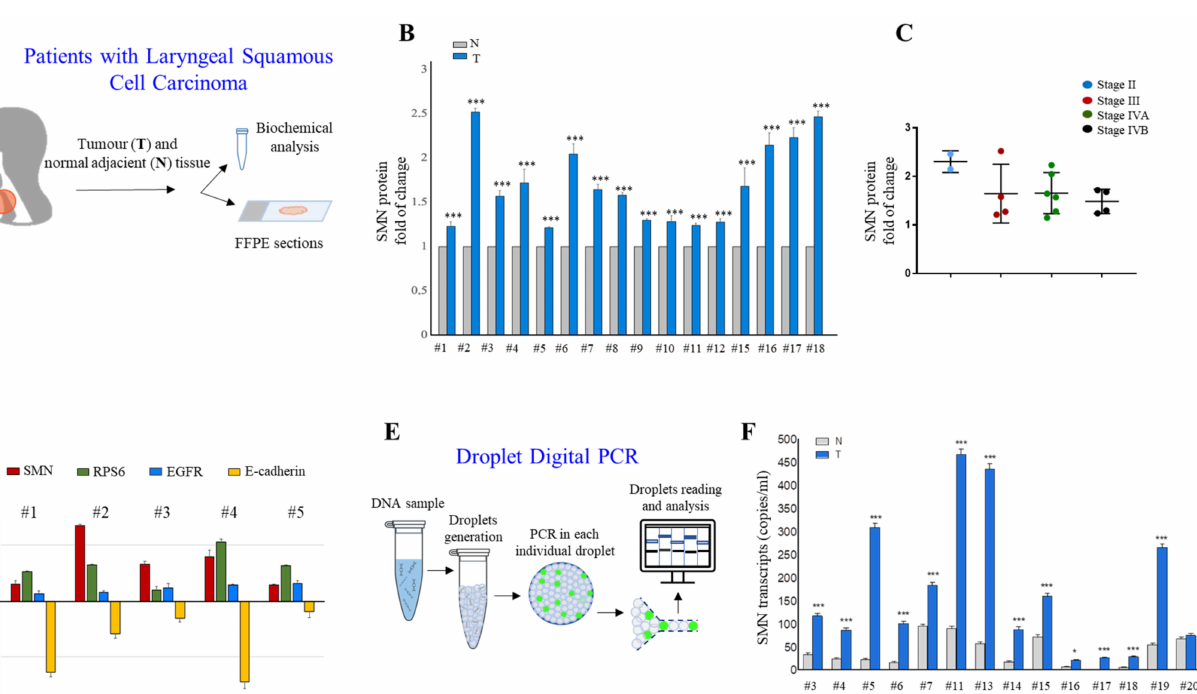
Figure 1. SMN is overexpressed in laryngeal squamous cell carcinoma. ( A ) Schematic representation of this pilot study. Within a cohort of 20 patients with LSCC, sample tissues from n = 16 patients were subjected to protein analysis, sample tissues from n = 14 patients were subjected to RNA analysis, and sample tissues from n = 2 patients to fluorescence microscopy. ( B ) Densitometric analysis of immunoblots using an anti-SMN monoclonal antibody. In each sample, SMN immunoreactivity was normalized to that of glyceraldehyde 3-phosphate dehydrogenase (GAPDH). SMN protein levels in the sample from tumor tissues (Ts) are expressed as the fold change compared with the sample from normal adjacent tissues (Ns). The number (#) identifies patients in Table 1. The graph illustrates the mean of three independent experiments. Error bars represent s.d. Asterisks indicate significative differences using unpaired t -test (*** p < 0.01). ( C ) Comparison of the SMN protein fold changes in different stages of laryngeal cancers. The box-and-whiskers graph shows the median, interquartile range, minimum, and maximum from the following number of patients per group: n = 2 for stage II; n = 4 for stage III; n = 6 for stage IVA; n = 4 for stage IVB. Data are analyzed by one-way ANOVA–Bonferroni’s multiple comparisons test. Mean ± s.d. are illustrated. No significative differences are observed between the different stages. ( D ) Densitometric analysis of immunoblots using antibodies against SMN, RPS6, EGFR, or E-cadherin. The immunoreactivity for each protein was normalized to that of GAPDH. Protein levels in tumor tissues (Ts) are ex-pressed as fold change compared with normal adjacent tissues (Ns). The mean of three independent experiments is shown in logarithmic scale (log2). Error bars represent s.d. ( E ) Diagram illustrating the main experimental steps of Droplet Digital PCR (ddPCR). ( F ) SMN mRNA expression levels (mean ± S.D.) measured by ddPCR comparing normal tissue (N) with tumor tissue (T) samples. The number (#) identifies patients in Table 1. Statistical significance of differences was evaluated by ANOVA followed by Bonferroni’s post-test: *** p < 0.001; * p < 0.05 (for each normal vs. tumor